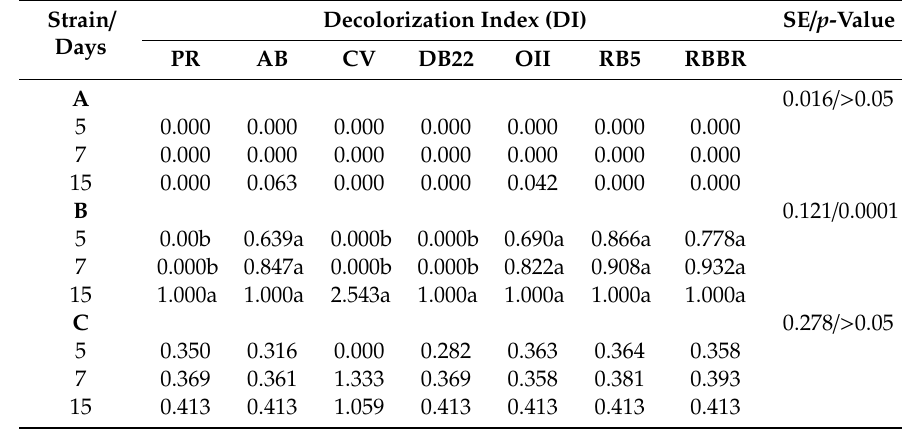
Table 2. Solid-plate dye decolorization in Bran Flakes (BF) medium supplemented with 200 ppm of each of the dyes evaluated.